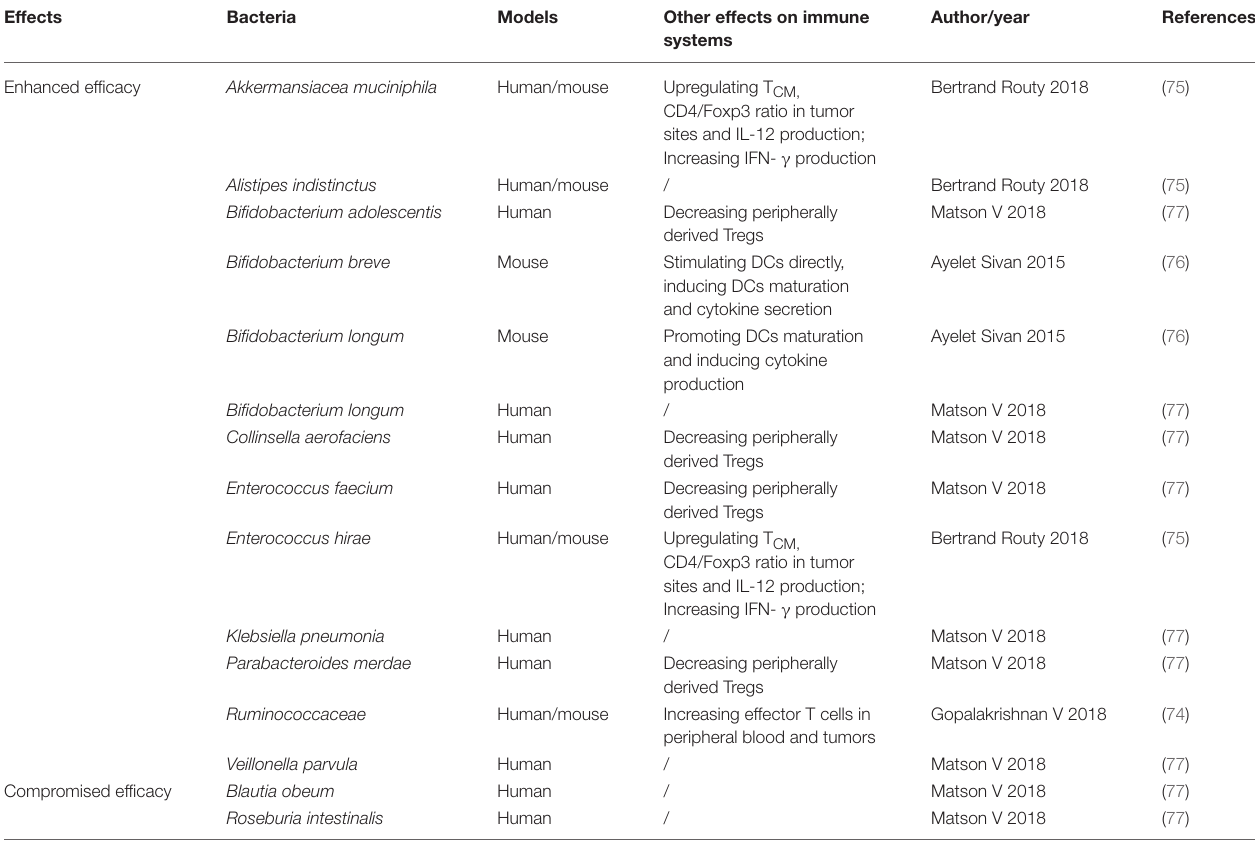
TABLE 3 | Gut microbiome affecting efficacy of PD-1/PD-L1